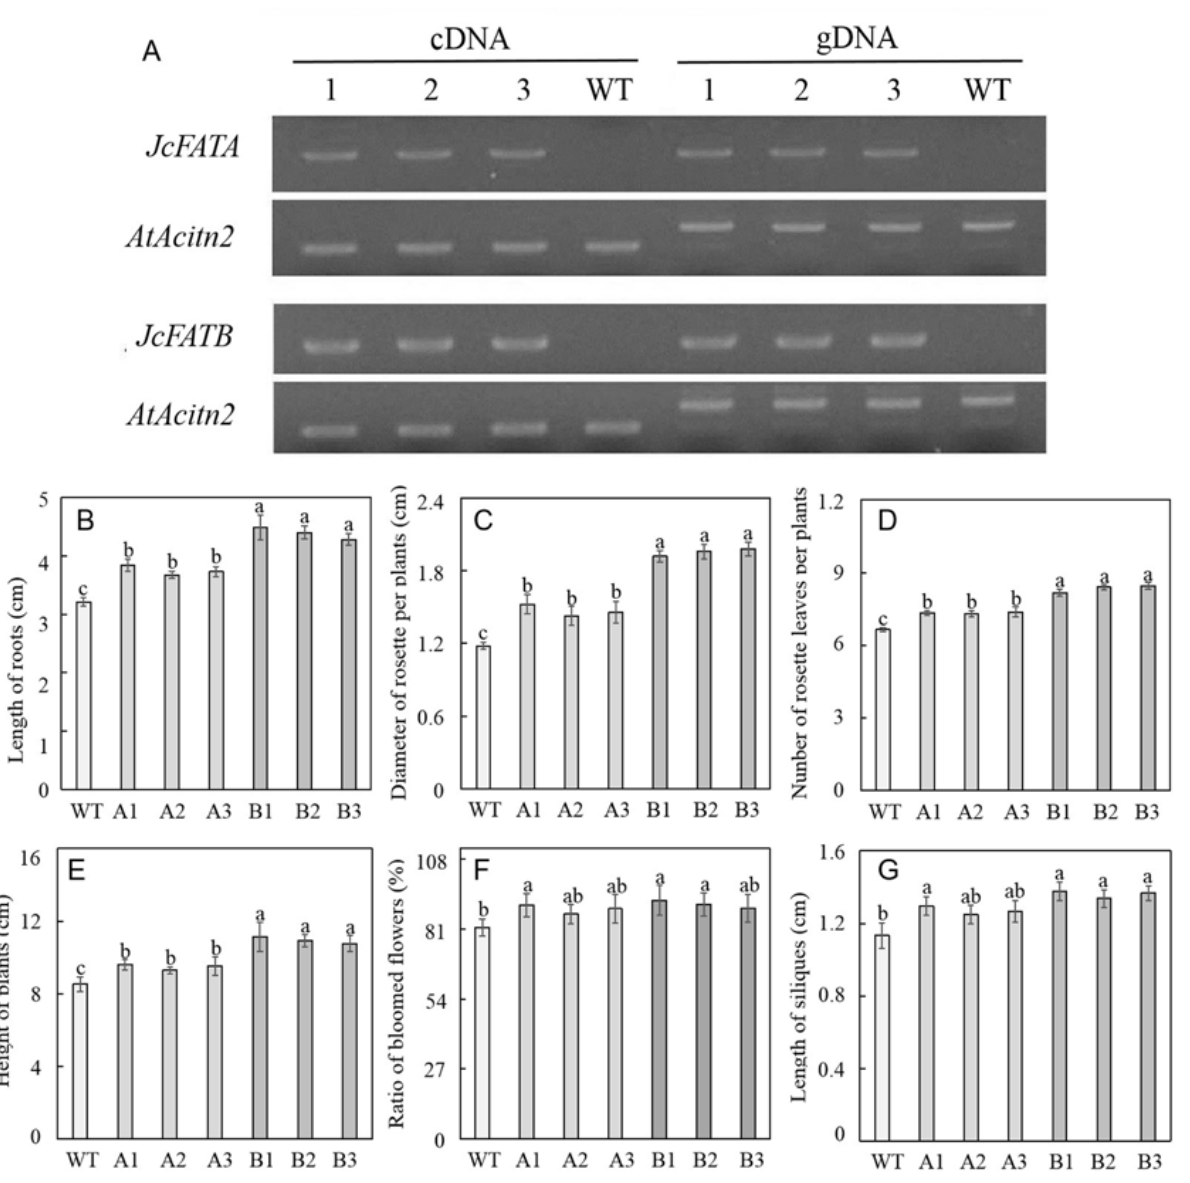
Figure 4. Heterologous expression of JcFATA and JcFATB promoted plant growth and development of A. thaliana. ( A ) Molecular characterization of 3 JcFATA (1, 2, 3) and 3 JcFATB (1, 2, 3) ectopic expression lines by semi-quantitative RT-PCR and PCR analysis. Wild-type ecotype Columbia (Col-0) was used as the negative control. ( B ) Root length of the 8-DAT (days after transplanting) A. thaliana plants expressing JcFATA and JcFATB . ( C,D ) Diameter and number of rosette leaves of the 20-DAT A. thaliana plants expressing JcFATA and JcFATB . ( E , F ) Plant height and bloomed ratio of the 28-DAT transgenic A. thaliana plants expressing JcFATA and JcFATB . ( G ) Silique length of the 50-DAT A. thaliana plants expressing JcFATA and JcFATB . Each value was the mean of three measurements. Error bars = SD (standard deviation). Data within a column followed by different letters (a, b, and c) are significantly different at p ≤ 0.05 as determined by Duncan’s multiple range test. Table 1. Mature seed size and weight of the JcFATA and JcFATB ectopic expression lines of A. thaliana.